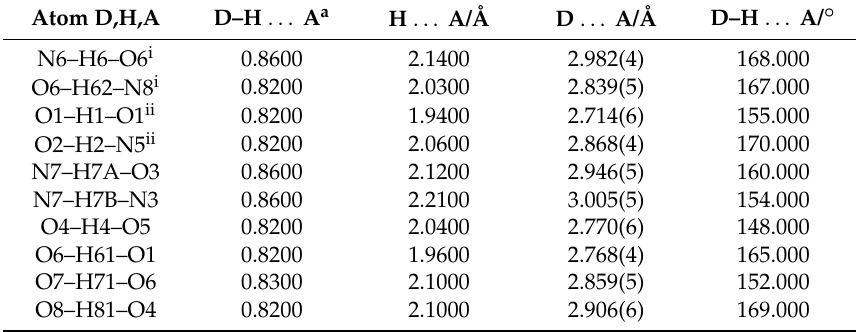
Table 2. Geometrical parameters for the intermolecular interactions of TICA-NCA hydrate. Atom D,H,A